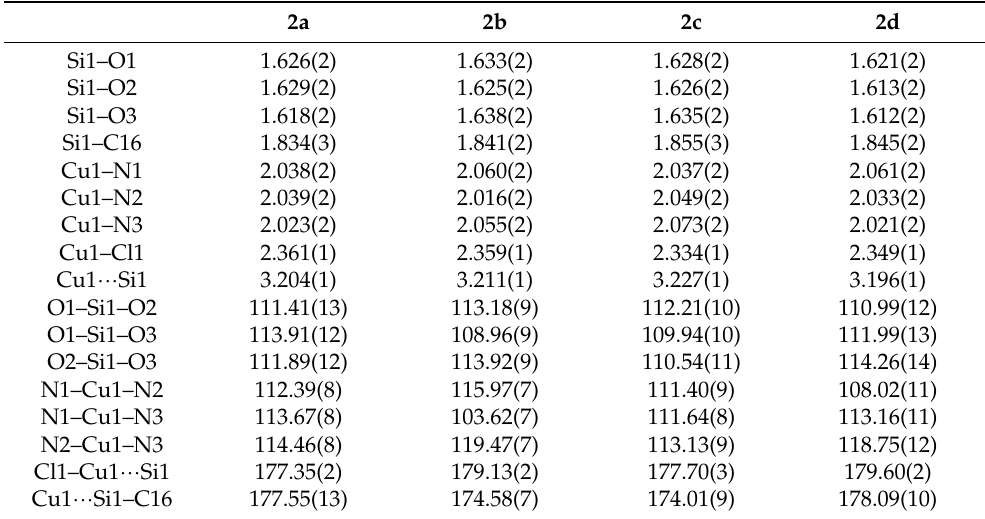
Figure 3. Molecular structures of ( a ) 2b (in the crystal structure of the solvate ( 2b ) 2 ·THF), ( b ) 2c and ( c ) 2d with thermal displacement ellipsoids at the 50% probability level and labels of selected non-hydrogen atoms. Selected interatomic distances and angles are listed in Table 1. For compound 2d , only the predominant part (site occupancy 0.9) of the disordered molecule is depicted. Hydrogen atoms are omitted for clarity. Table 1. Selected atom distances (Å) and bond angles (deg) in compounds 2b , 2c and 2d in their crystal structures (as well as some corresponding parameters of one molecule of 2a [20], the crystal structure of which features two independent molecules).